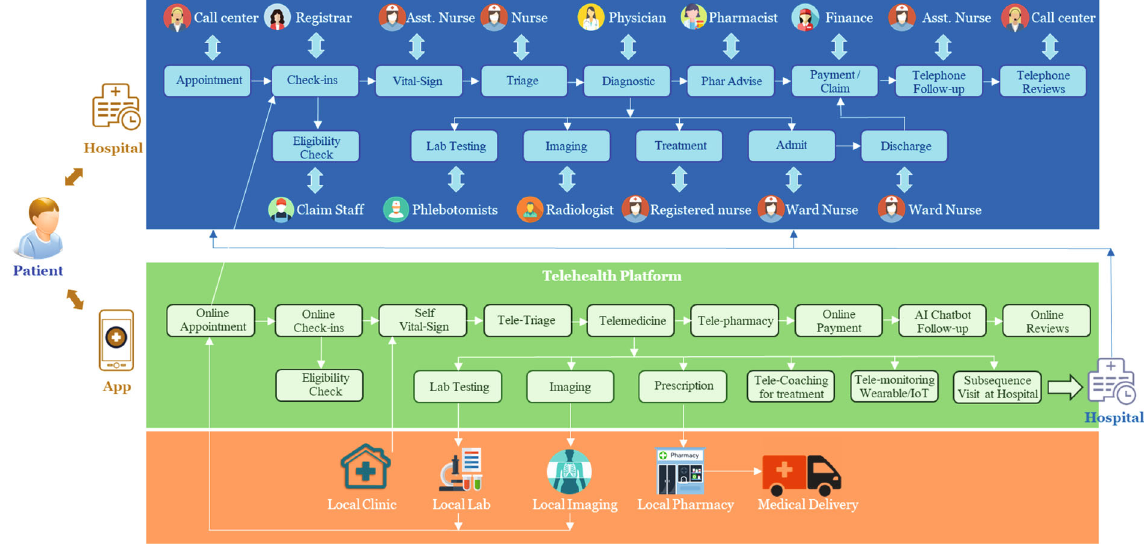
Figure 4: A hybrid design of patient